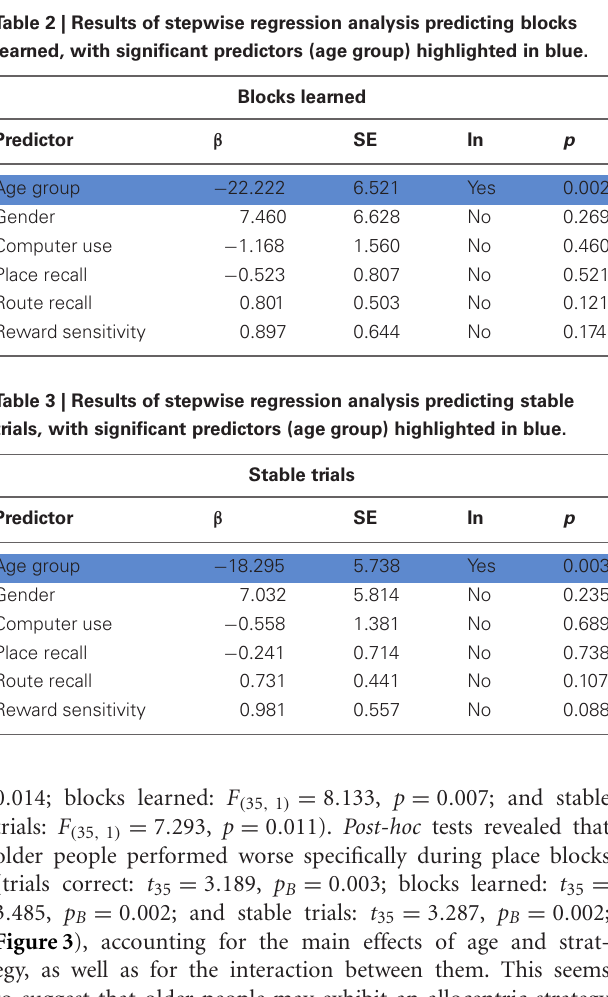
Figure 3 ), accounting for the main effects of age and